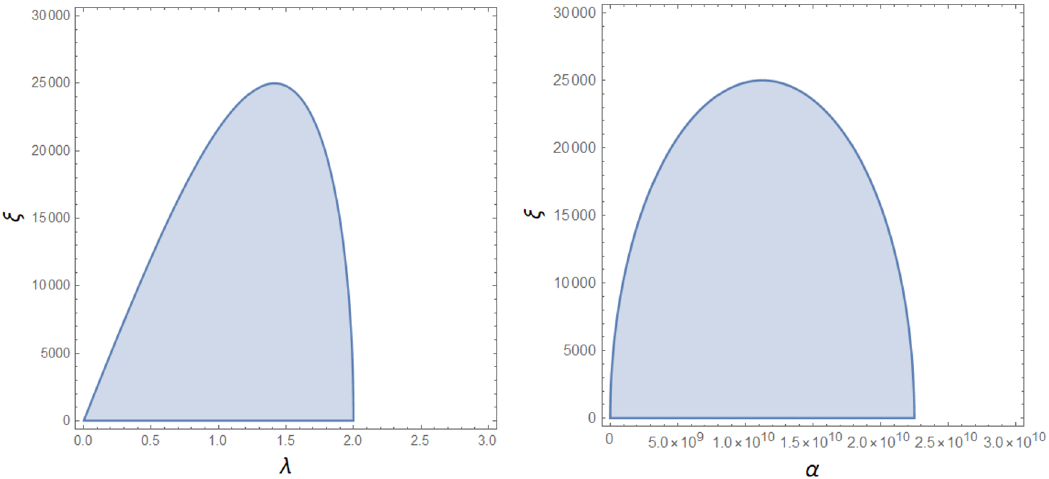
Figure 2 . The region allowed by perturbativity on λ, ξ, and α . We used the CMB normalization to express α ( λ ) in terms of the other parameters on the left (right)